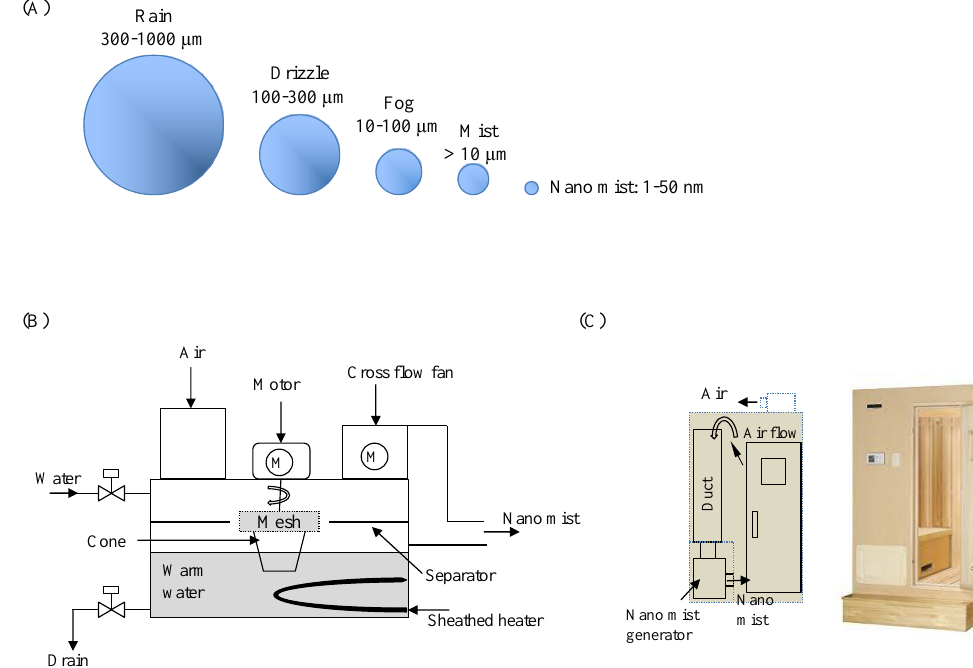
Figure 1. ( A ) Each size of water particles compared with nano mist. ( B ) System diagram of nano mist Figure 1. A ) Each size of water particles compared with nano mist. B ) System diagram of nano mist generation. ( C ) Outline of nano mist generation. C ) Outline of nano mist sauna.